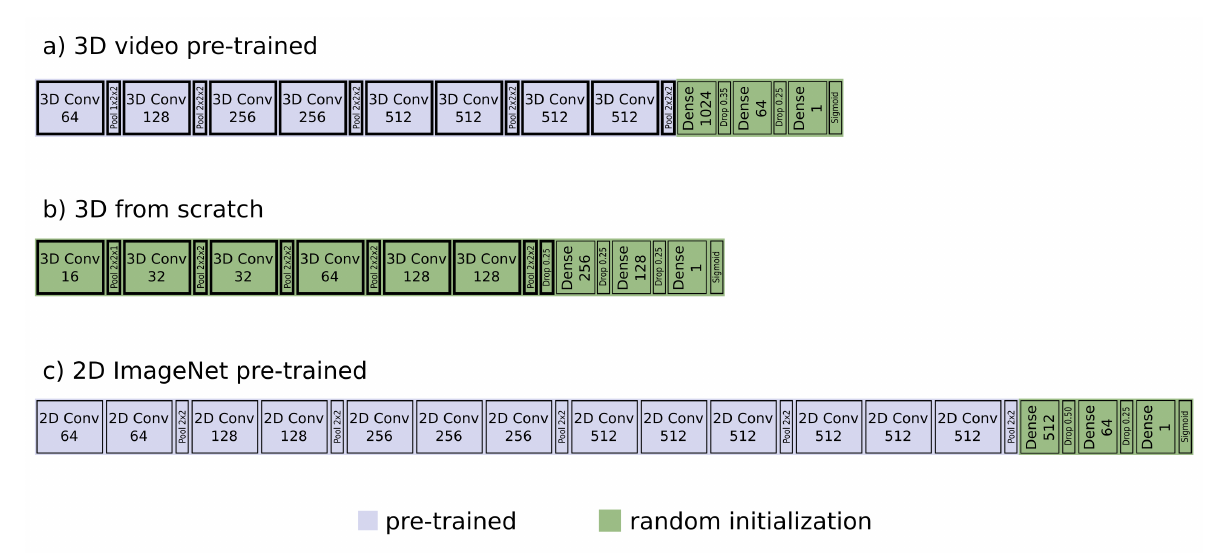
Figure 1. The convolutional neural networks. With ( a ), the network pre-training on the video data of the 1M sports data set. All convolutional layers (Conv) were kept fix, while the fully connected layers (Dense) were replace by randomly initialized ones. ( b ) shows the CNN trained with all layers randomly initialized. Network size was reduced in comparison to ( a ), max-pooling (Pool) was applied earlier and dropout (Drop) was already used in the last convolutional layer. ( c ) the 2D architecture, pre-trained on ImageNet. As base line model VGG16 was used, all convolutional layers were kept fixed, dense layers were replaced and randomly initialized.